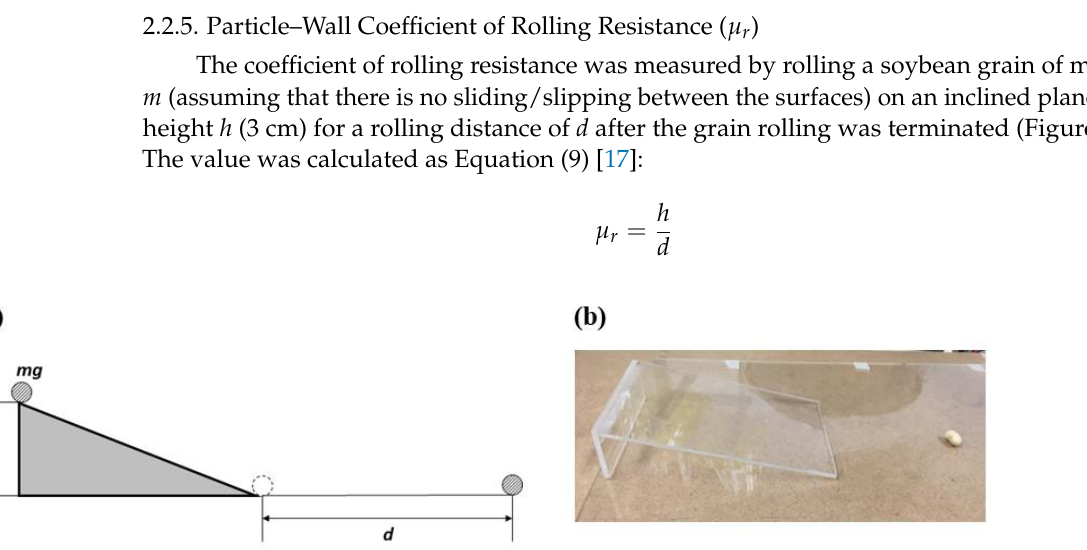
Figure 3. Schematic apparatus and method to determine the particle – wall coefficient of restitution ( a ) and the image taken during the experiment ( b ).